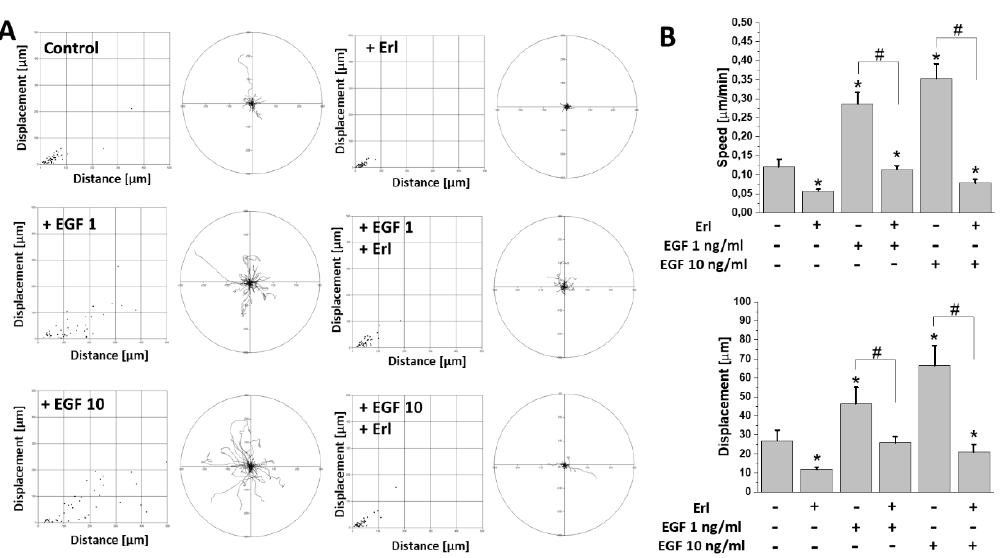
Figure 2. EGF augmented migration activity of GBM cells in vitro. ( A ) The effect of 72 h exposure of GBM cells to EGF and/or Erl. Dot plots represent displacement (X axis) and total length of trajectory (Y axis) calculated for single analyzed cells. Circular plots depict trajectories of individual cells. ( B ) Quantitative analysis of parameters (speed, displacement) describing efficiency of cells’ migration activity changes in examined conditions. Note the highly pronounced stimulation of cellular motility by EGF. Bars represent S.E.M.; n = 40. Statistical significance was calculated with non-parametric Mann–Whitney test, * p < 0.05 vs. control; # p < 0.05 vs. reference condition.